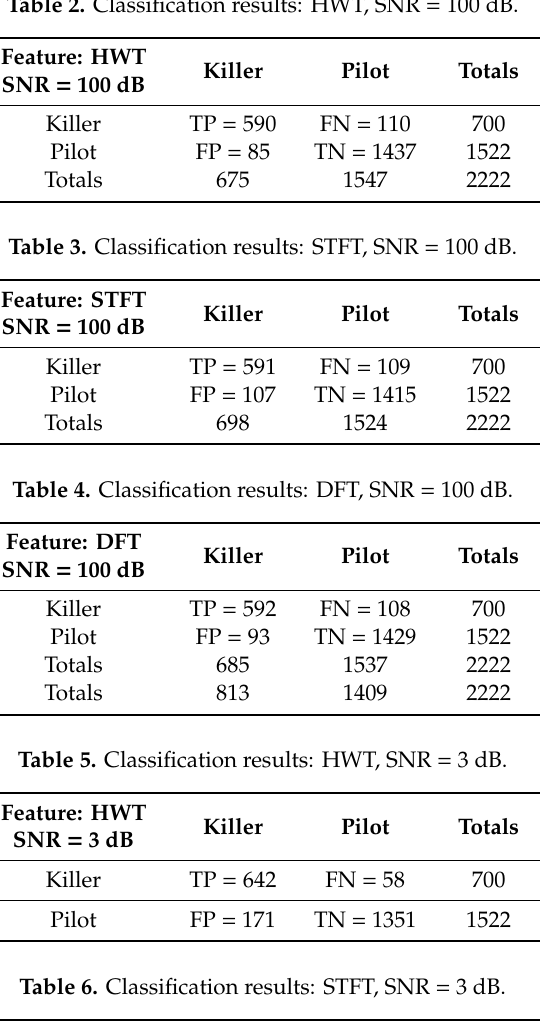
Table 2. Classification results: HWT, SNR = 100 dB.